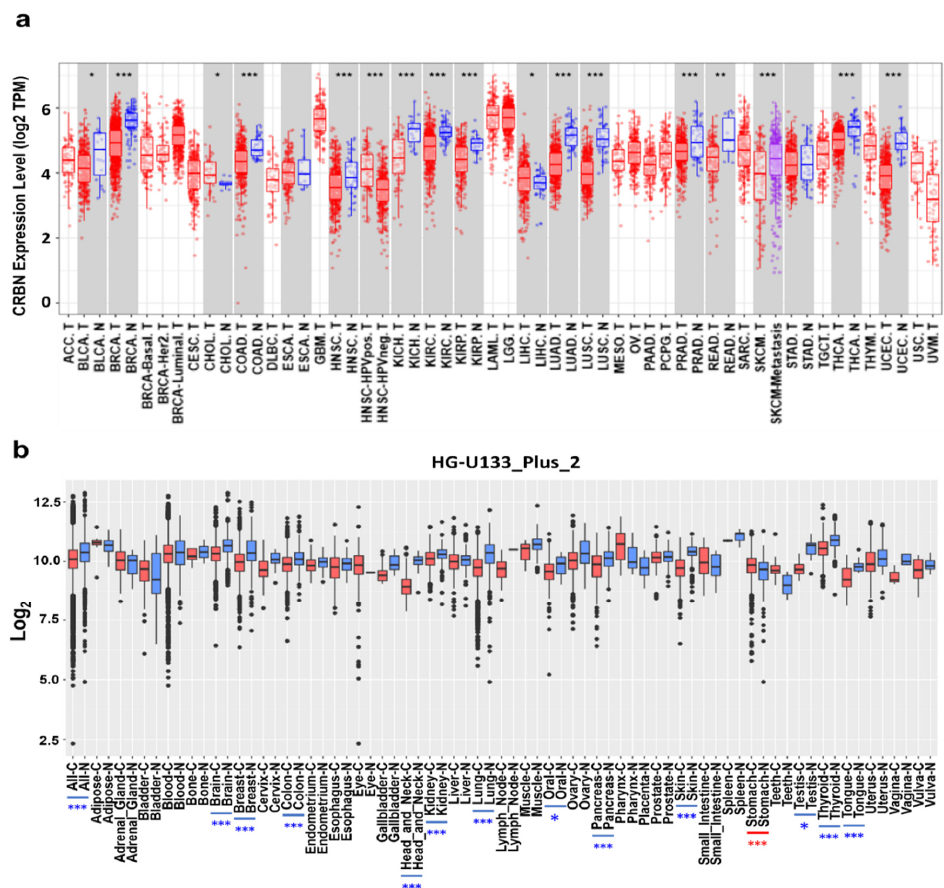
Figure 1. CRBN mRNA expression in various cancer types and corresponding normal tissues. ( a ) CRBN expression in different types of human cancer and normal tissues was determined from RNA-sequencing data from the Cancer Genome Atlas (TCGA) database using the Tumor IMmune Estimation Resource (TIMER) web tool (https://cistrome.shinyapps.io/timer/, accessed on 28 July 2020). Significant differences between each type of tumor and normal tissues were marked with asterisks (* p < 0.05, ** p < 0.01, *** p < 0.001). Abbreviations of cancer types are listed in Supplementary Materials Table S2. The letters “T” and “N” followed by the tumor type abbreviation indicate “tumor” and “normal,” respectively. ( b ) mRNA expression patterns of CRBN across various types of tumor and normal tissues were retrieved from the Gene Expression Database of Normal and Tumor Tissues 2 (GENT2) (http://gent2.appex.kr/gent2/, accessed on 28 July 2020). Boxplots were generated to illustrate the median and the 25th and 75th percentiles; the dots represent the outliers. Red boxplots represent cancer samples, and blue boxplots represent normal samples. Significant differences between each type of tumor and its normal counterpart are marked by blue asterisks (higher expression in normal tissue) or red asterisks (higher expression in the tumor).